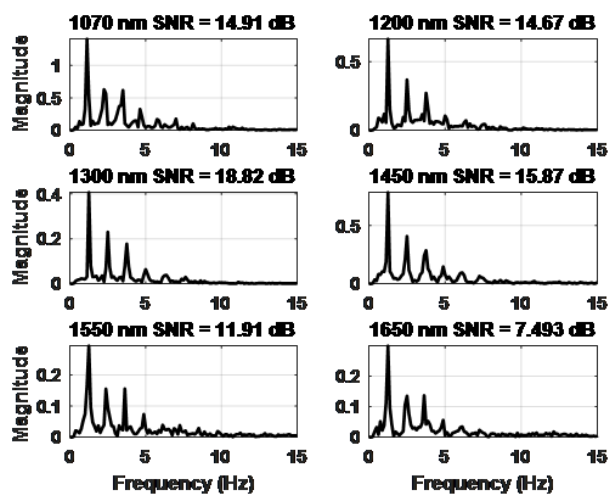
Fig. 11. The spectrum of PPG signals and SNR values.